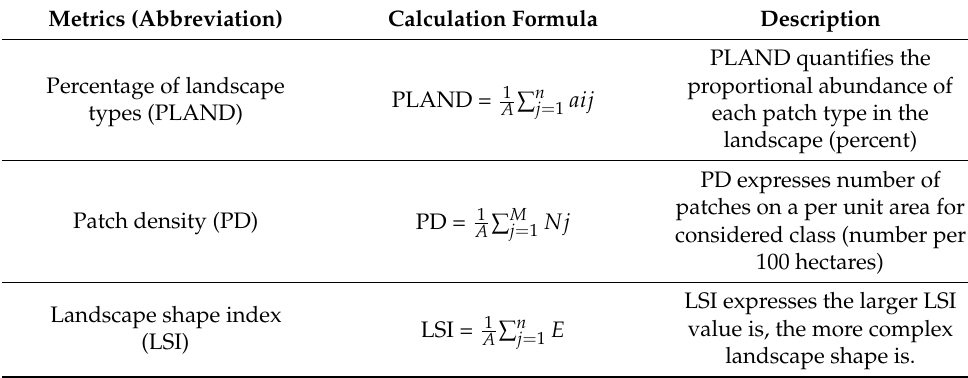
Table 2. Landscape pattern